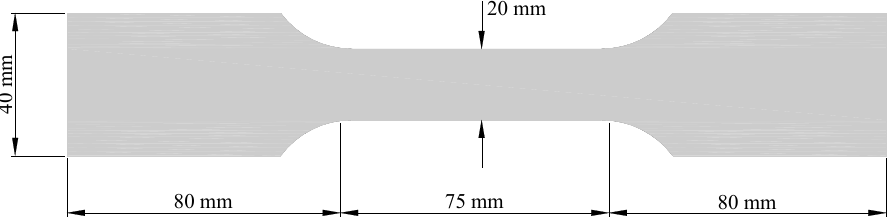
Figure 1. Geometry size of tensile steel samples.